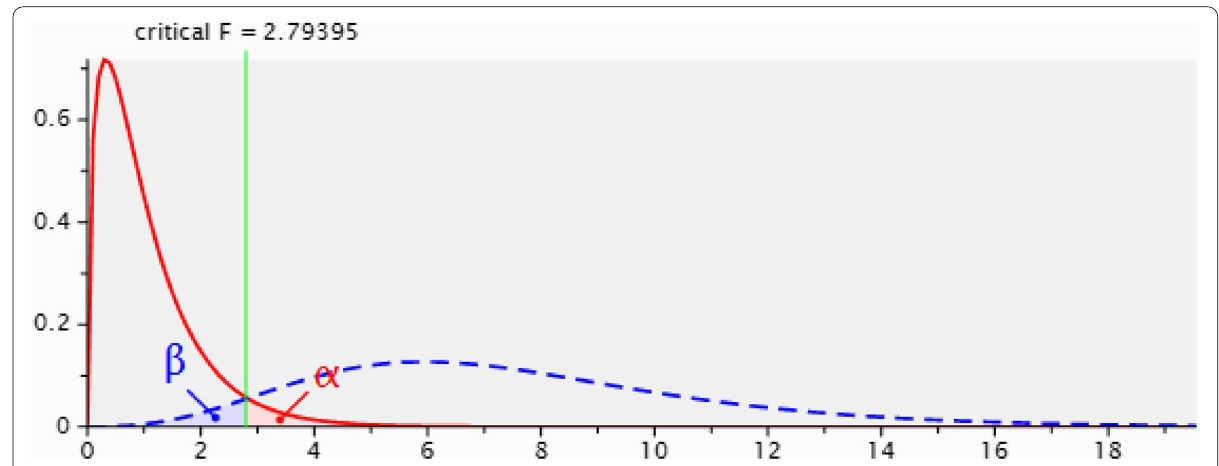
Fig. 1 The outcome of the power calculations showing the critical F , β, and α corresponding